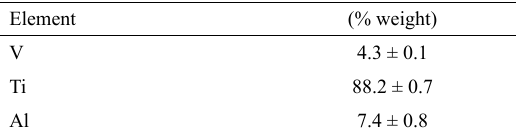
Table 1. Chemical composition of the Ti6Al4V alloy. Element